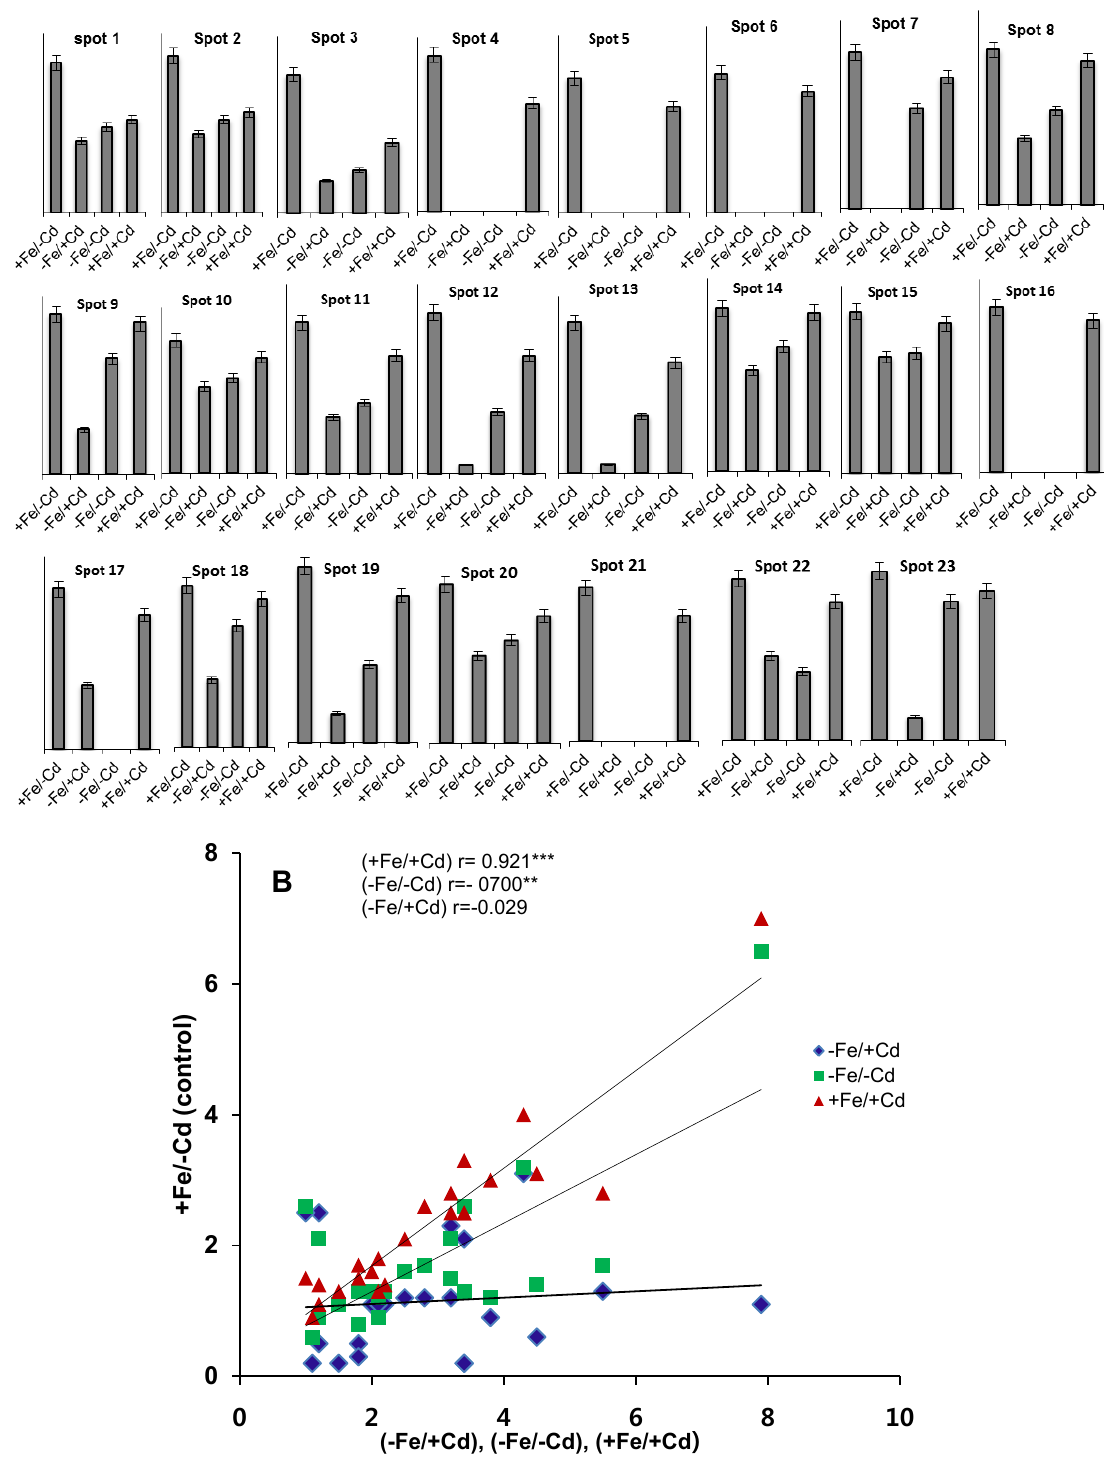
Figure 2. ( A ) Relative intensities expressed as fold change; ( B ) Linear correlation compared to control 10 days of Fe/Cd combined treatments, sufficient in iron and no cadmium (+Fe/−Cd, control), deprived iron and cadmium toxicity (−Fe/+Cd), deprived iron with no cadmium (+Fe/−Cd), and sufficient iron but cadmium toxicity (+Fe/+Cd) in the roots of Vigna radiata L. The relative intensity was quantified by PD-Quest software.